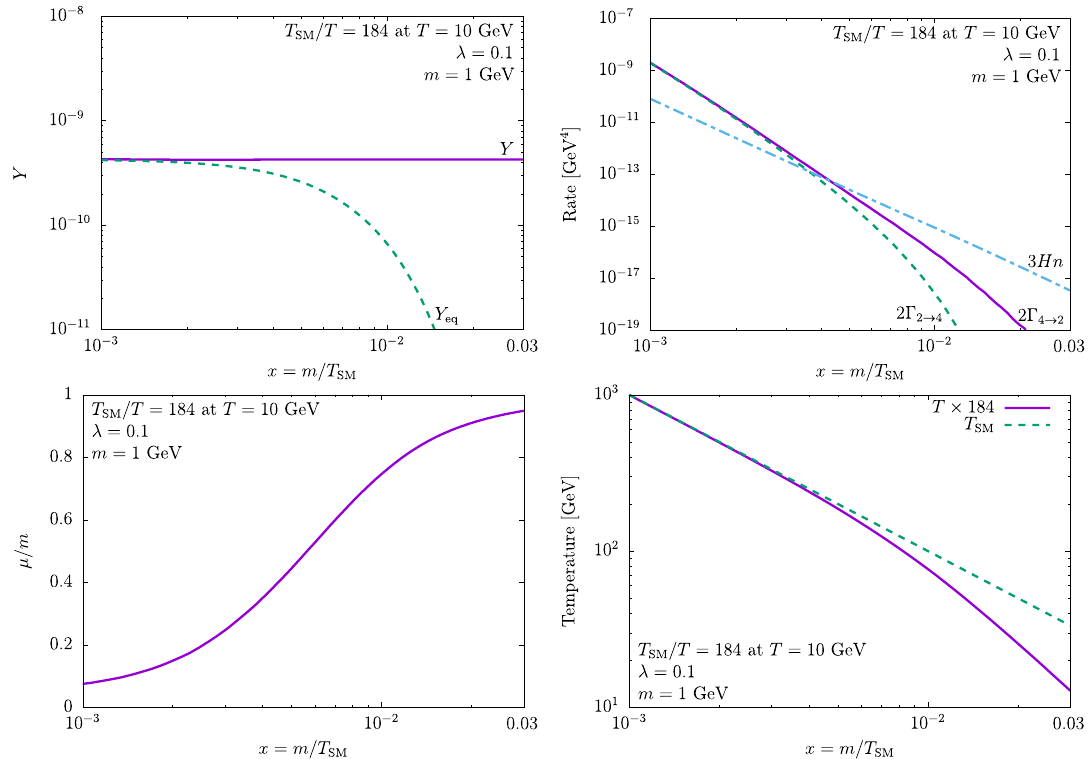
Figure 5 . Thermodynamic quantities as a function of x for relativistic freeze-out. Here T f 1 . 2 GeV.